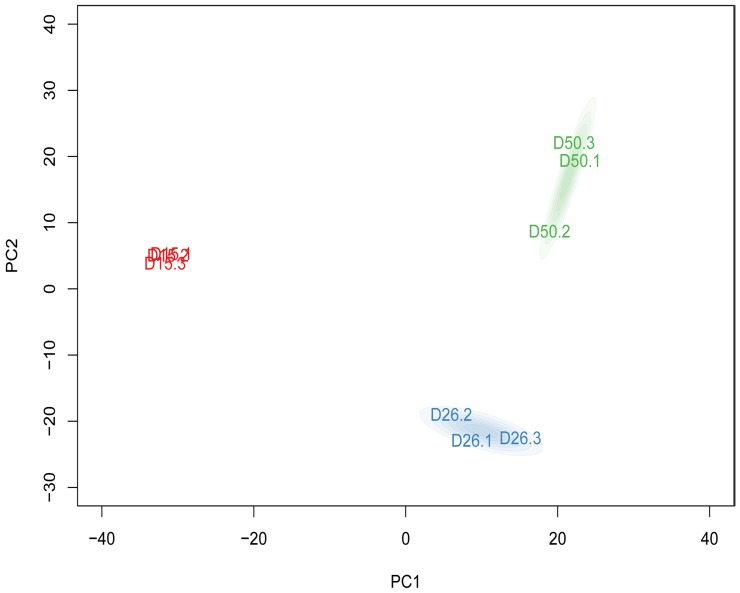
Principal Component Analysis (PCA) plot of microarray data in porcine endometrium.In each case, three replicates from each gestational day cluster together. Clustering of the samples according to gestational day is shown. The red, blue and green circles stand for three different gestational days. D15: gestational day 15; D26: gestational day 26; D50: gestational day 50.